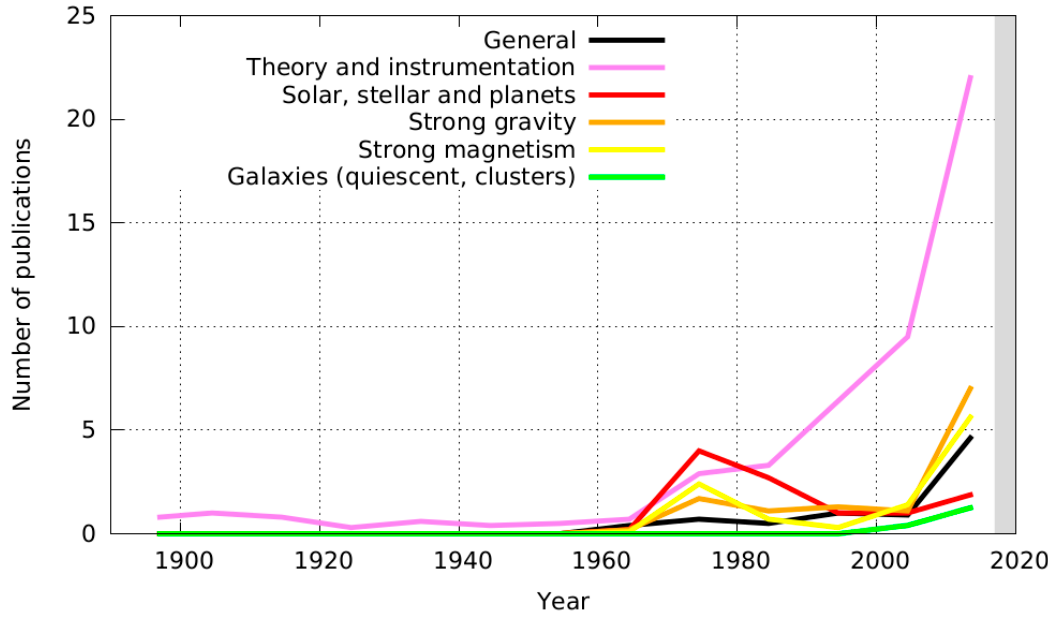
Figure 2. Number of publications focusing on astronomical X-ray polarimetry as a function of time. Several subcategories are highlighted: the black solid line represents general publications on X-ray polarimetry (reviews, historical notes); violet stands for publications concerning theory, instrumentation, and satellites, red for papers on solar, stellar, and exoplanet science; orange for papers on objects dominated by strong gravity effects (e.g., black holes); yellow for objects dominated by strong magnetic fields (e.g., neutron stars); the green solid line stands for papers related to galaxies (e.g., galaxy clusters or the Milky Way).